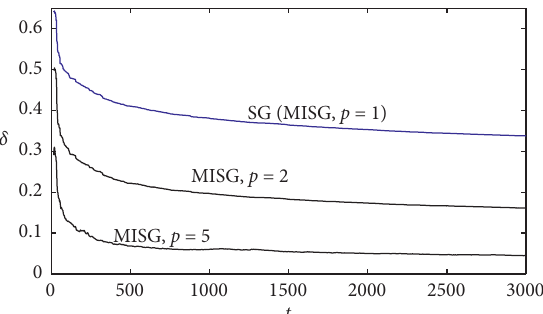
Figure 4: The state and state estimate 􏽢 x ( t ) ; dots: the estimated 􏽢 x true x 2